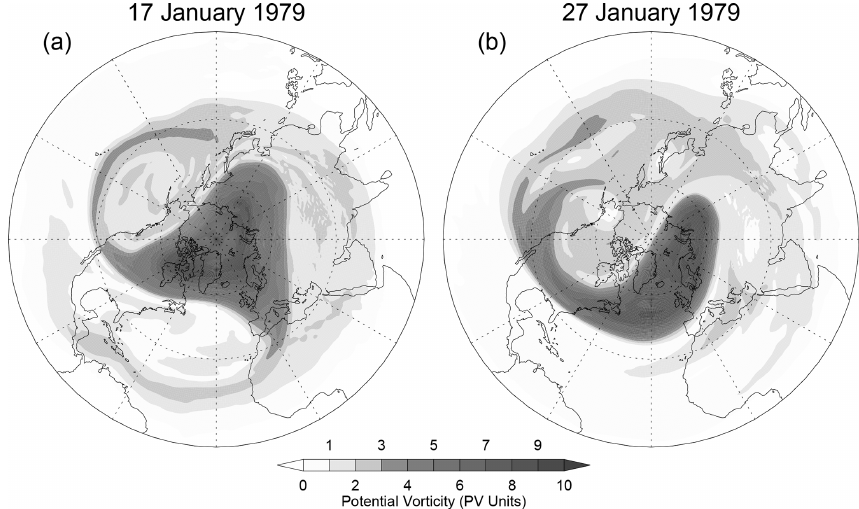
Figure 5. Potential vorticity on the 850K isentropic surface ( ∼ 10hPa) for (a) 17 January and (b) 27 January 1979. Figure 2 from McIntyre and Palmer (1983) updated using PV derived from ERA-Interim (Dee et al., 2011) data. Note that in January 1979 observations of middle stratosphere were still rather sparse and therefore the extra detail in the updated maps is a manifestation of the reanalysis of the data.